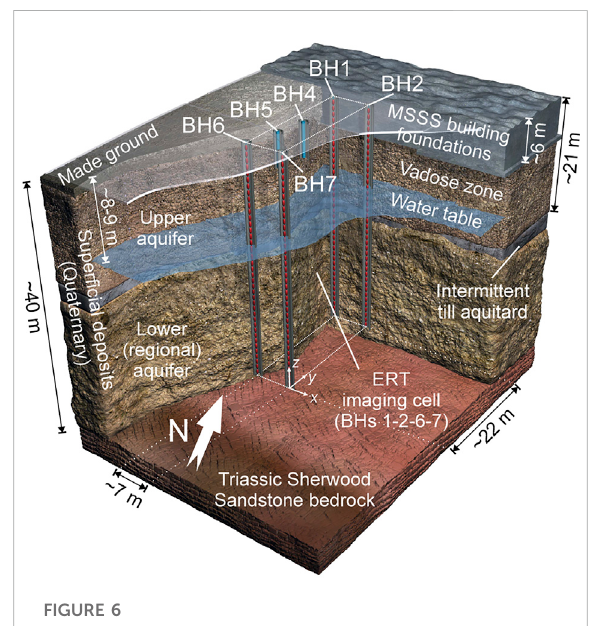
FIGURE 6 Conceptual ground model and geometry of vertical electrodearraysdeployedattheMSSSfacility.Electrodeboreholes areindicatedbybluecylinderswithredpointsshowingelectrodes, shorter blue cylinders indicate tracer release